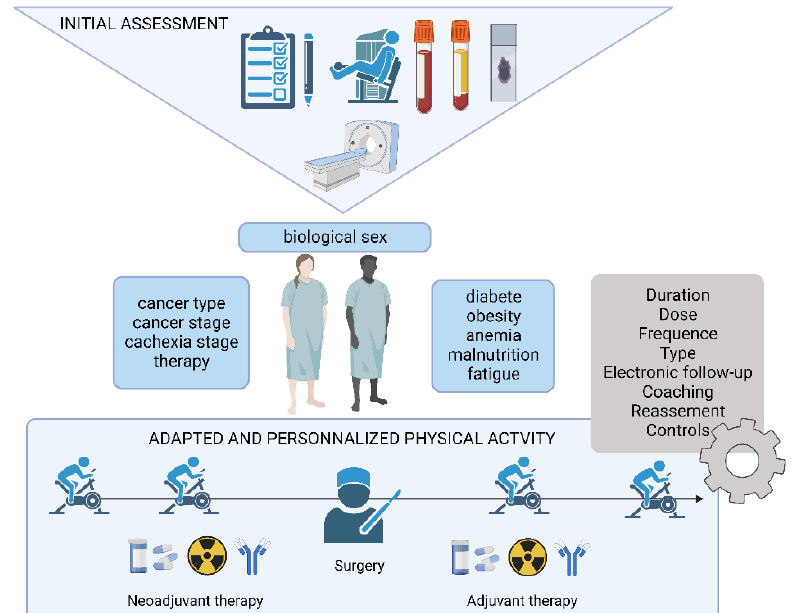
Figure 3. Limits and parameters to include in the APA set-up. The initial assessment must include different markers and observations (e.g., CT scan, questions, physical test, blood draw, biopsies) to help build an APA around the scheme of therapy of the treatment (diagnosis, neoadjuvant therapy, after surgery and after remission). Created with BioRender.com.